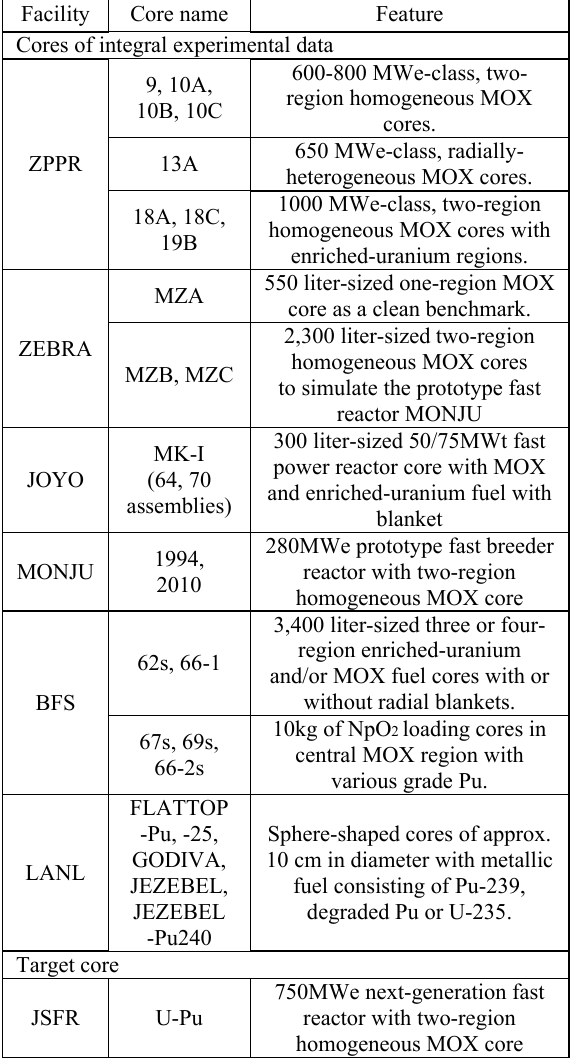
Table 1. Cores of integral experimental data and target